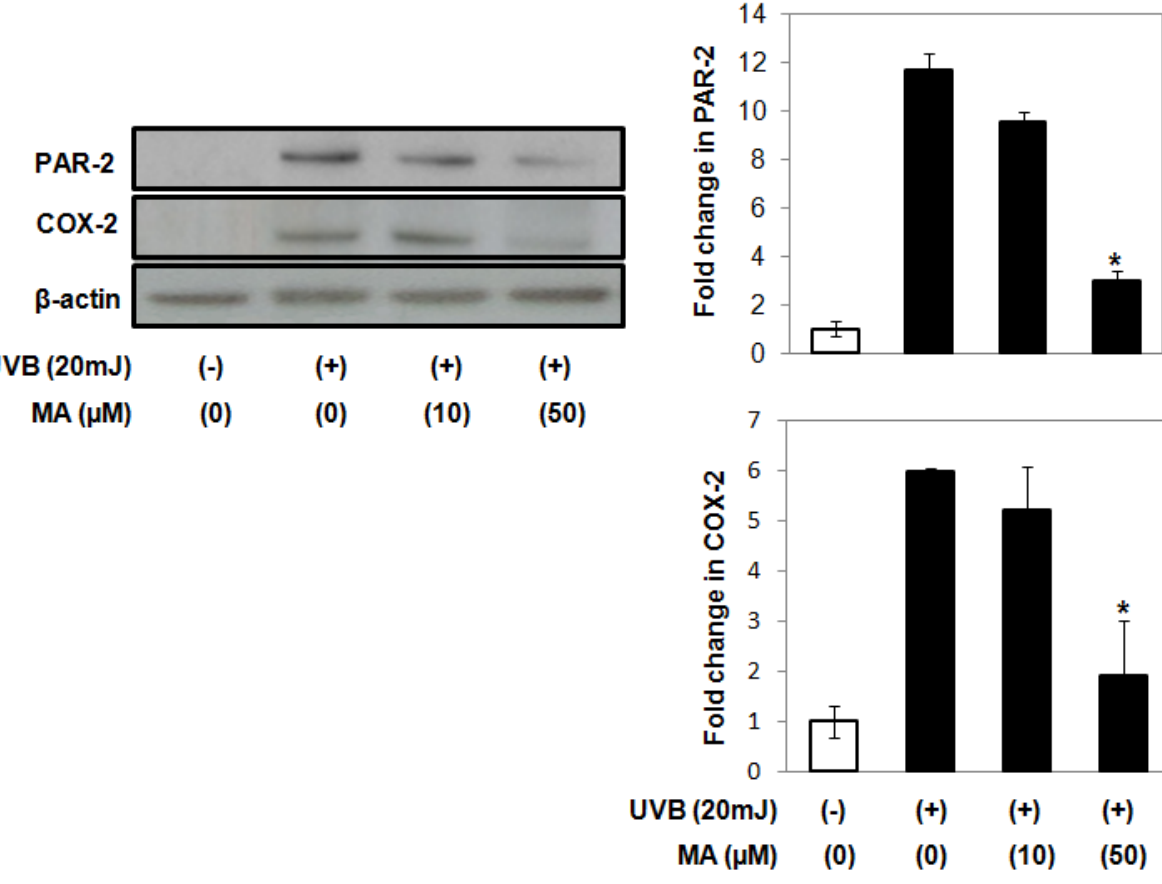
, ( b ) PGF α . The data 2 2